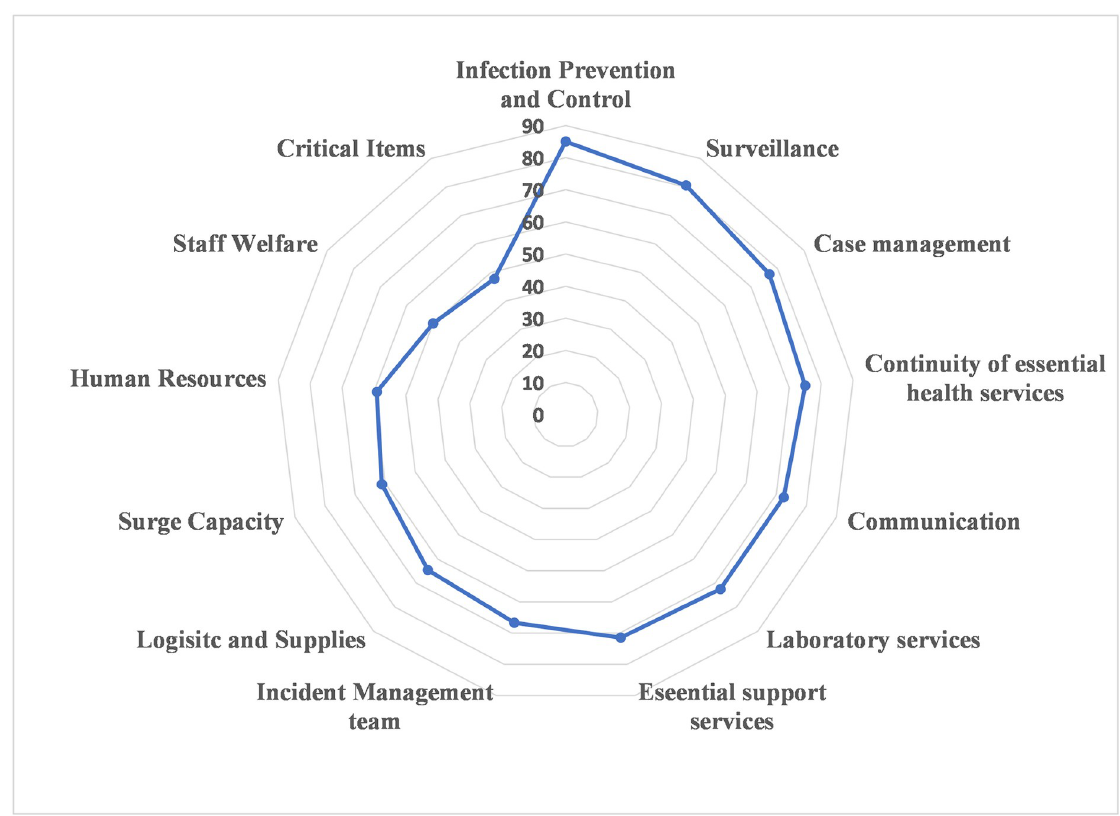
Fig 1. Radar chart of readiness scores (%) of 13 components of WHO modified COVID-19 hospital readiness checklist among 20 hospitals in Nigeria.